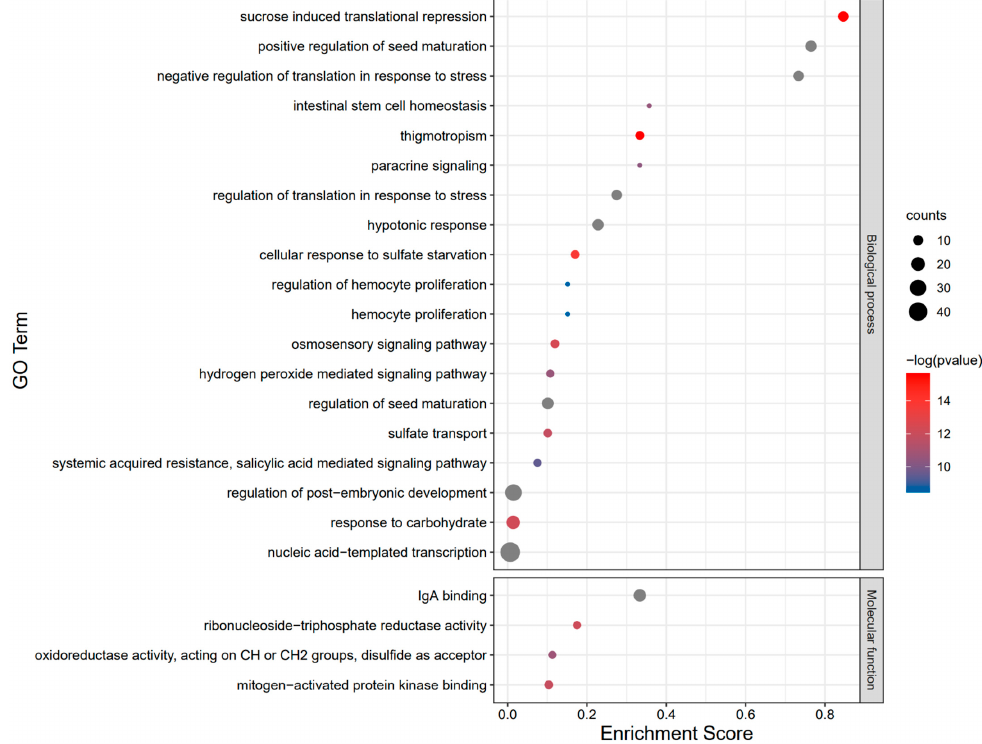
Figure 11. GO enrichment analysis of the BvbZIP genes. The horizontal axis represents the enrichment degree of genes in corresponding items, and the vertical axis shows the 23 items with the highest enrichment degree of the BvbZIP genes, among which the negative regulation of stress response is the key analysis item. The size of the circle represents the number of genes enriched in the corresponding project, and scale ranging from blue to red represents the p value from large to small, and gray represents a p value of 0.